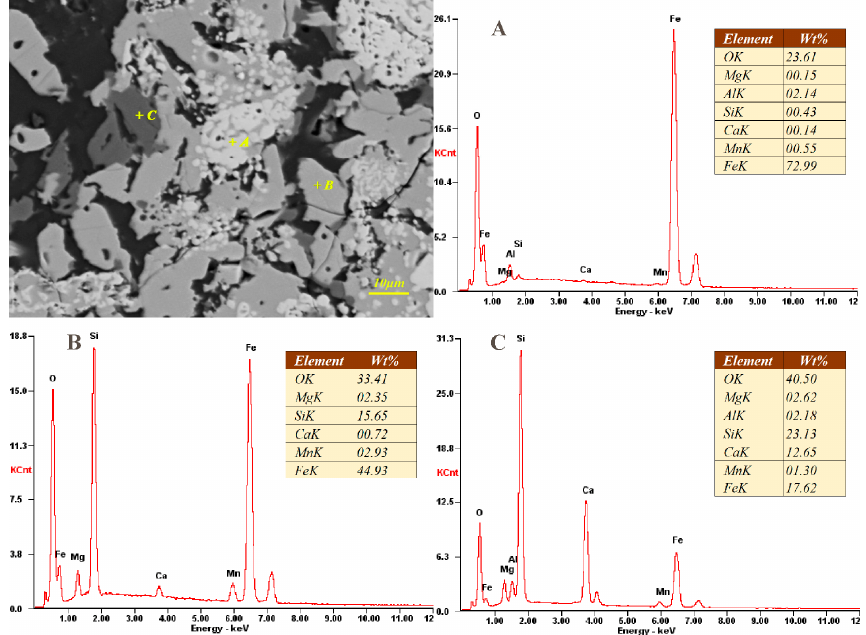
Figure 7. SEM-EDS analysis of internal deposit sample (S2).